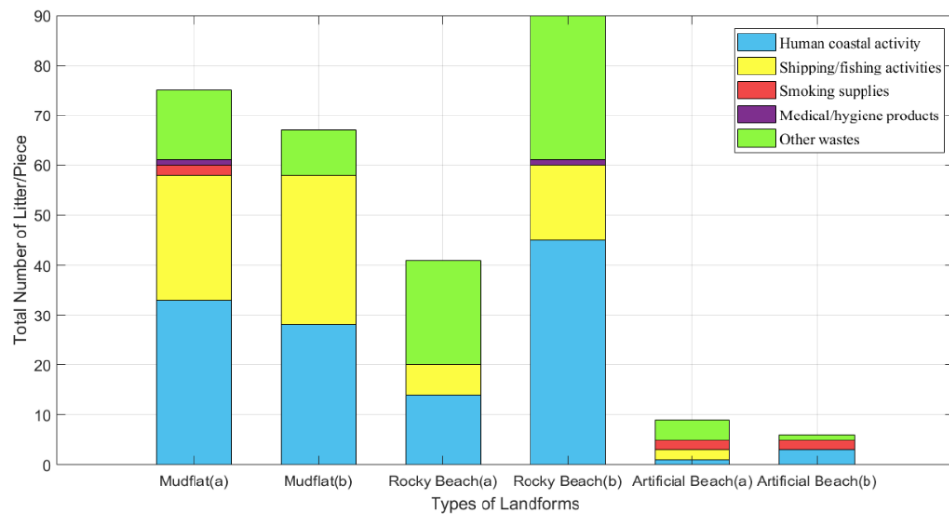
Figure 4. Proportion chart of marine litter sources from the survey samples.